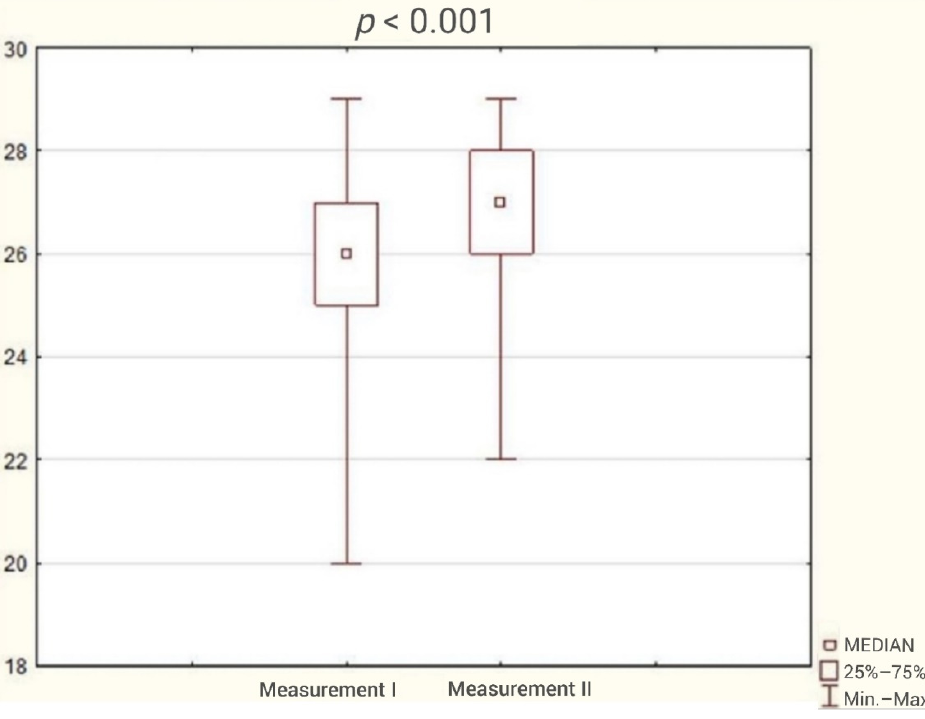
Figure 4. Patient result in Montreal Cognitive Assessment Scale (MoCA) during the first and second study (Wilcoxon test).